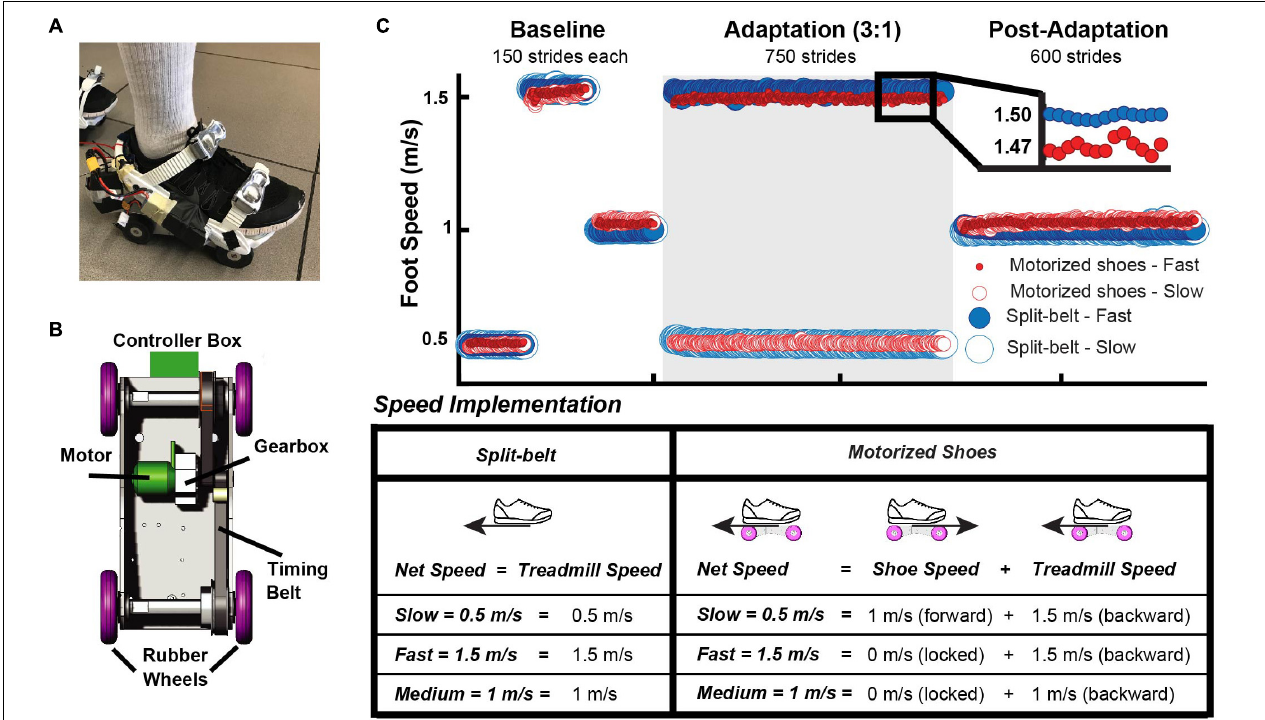
FIGURE 1 | (A) A motorized shoe involving proprietary technology was used to induce adaptation in the motorized shoes group. (B) Schematic of the motorized shoe. This consists of a motor, a controller box, a gearbox, two toothed timing belts, and four rubber wheels. (C) Mean time courses for foot speed across participants for the motorized shoes and the split-belt groups. The white background indicates experimental epochs of “tied” walking when both feet moved at the same speed, whereas the gray background indicates the epoch of “split” walking when the dominant leg moved three times faster than the non-dominant leg. The table summarizes the procedure used to set the slow, fast, and medium speeds for each foot. The same procedure was used in all epochs. It is worth pointing out that the treadmill always moved at 1.5 m/s during adaptation in the motorized shoes group. The speed difference between feet was achieved by locking the wheels on the fast side and moving the slow foot forward at 1 m/s to obtain a net speed of 0.5 m/s on the slow side. Of note, the foot’s speed on the fast side was slightly slower on the motorized shoes than the split-belt